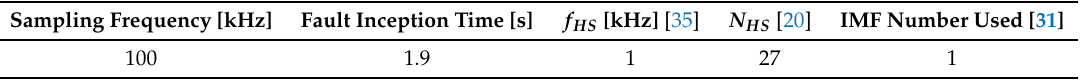
Table 3. System and algorithm parameter values used in the simulation